Question: State the chart type depicted above.
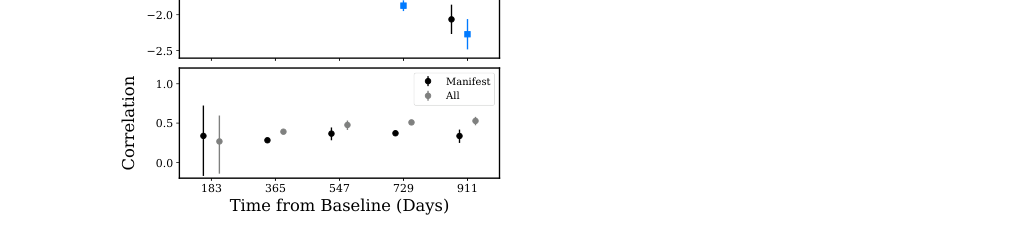
Answer: bar